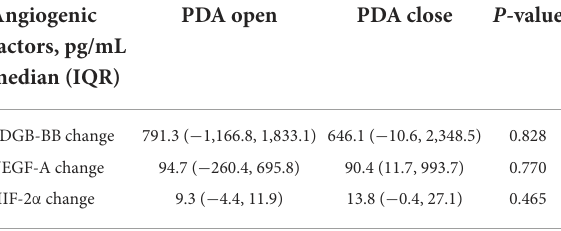
TABLE 2 Concentrations of angiogenic factors stratified by PDA status after ibuprofen treatment.